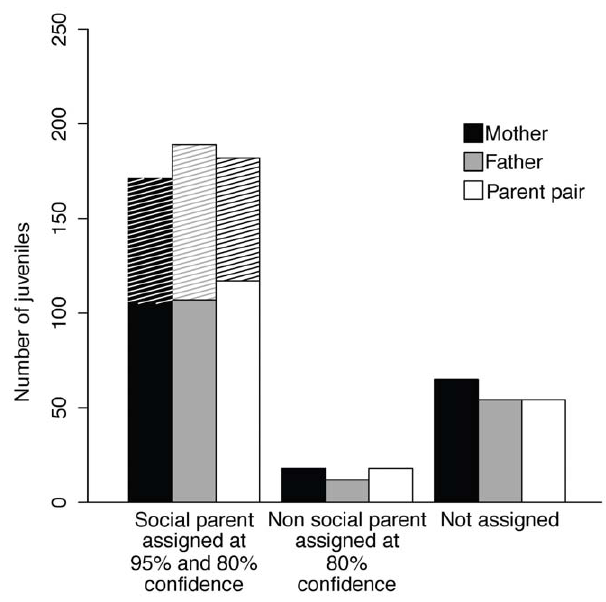
Figure 1. Number of maternities, paternities and parental pairs assignments. Numbers of maternities (black), paternities (grey) and assignments to parental pairs (empty) are given for i) the social parents (social mother, social father, and social parental pair) with 80% (total bars) and 95% (non-hatched bars only) confidence, ii) non social parents (mother, father and parental pairs) with 80% confidence; and iii) number of juveniles for which maternity, paternity and parental pairs could not be properly assigned with 80% confidence.